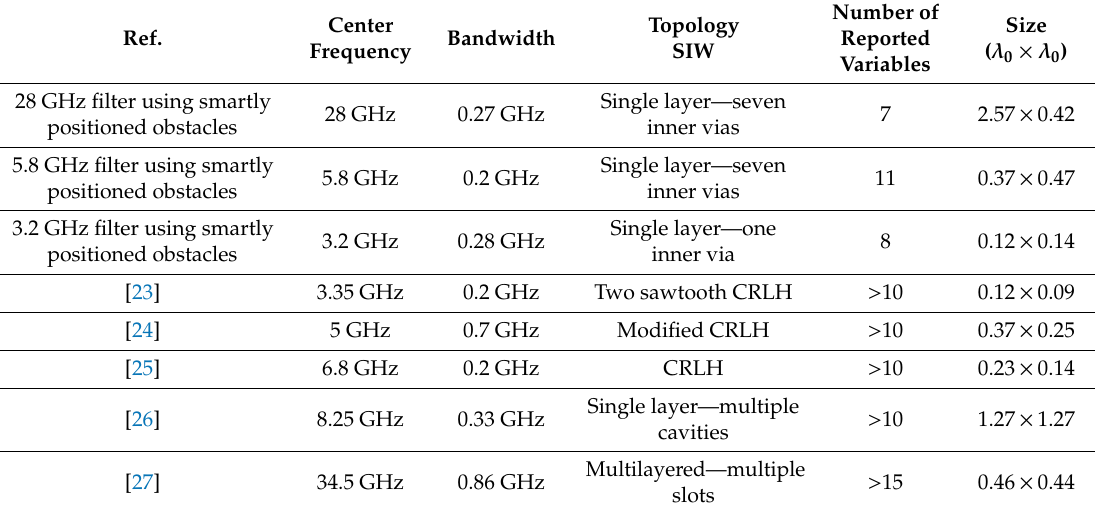
Table 1. Comparison of SIW filters. CRLH, composite right–left-handed.